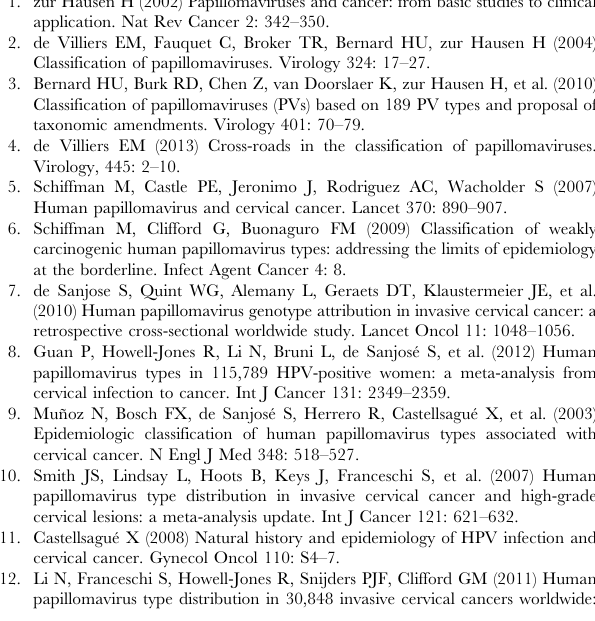
alignment for phylogenetic